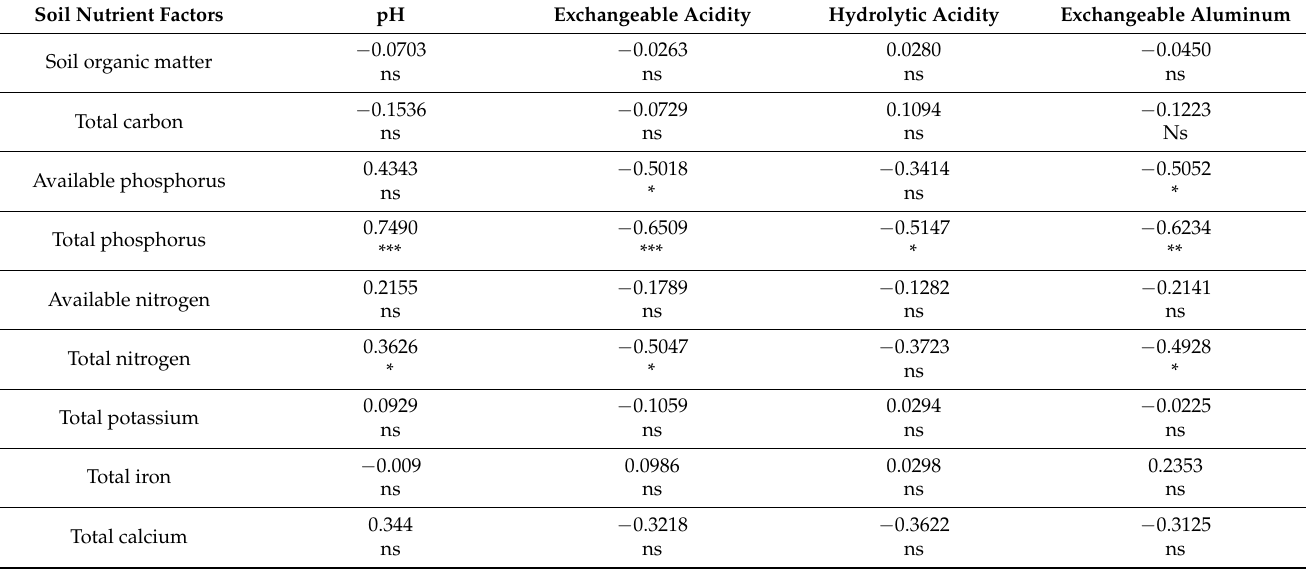
Table 2. Correlation coefficient between the soil cations (H + and aluminum) and soil nutrients.